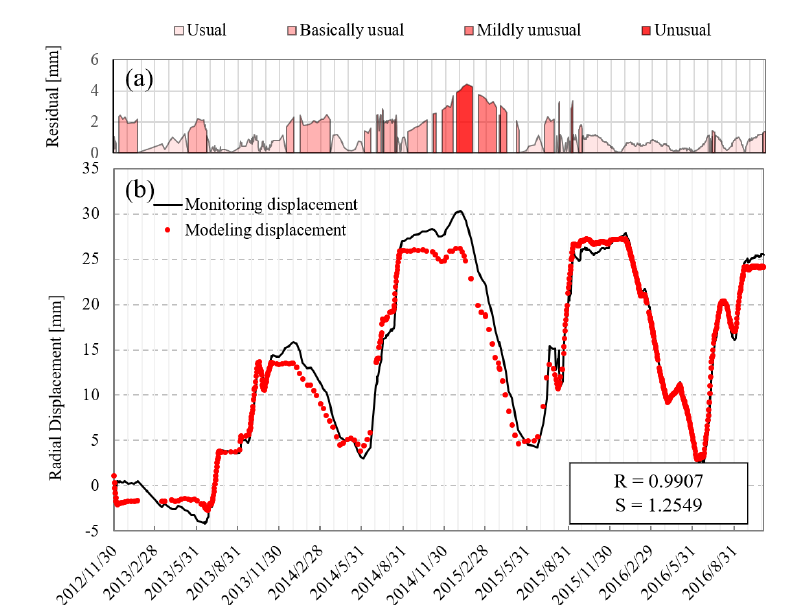
Figure 6. Time variation of ( a ) absolute residual and ( b ) modelled and monitored displacement data for the monitoring point PL9-3.